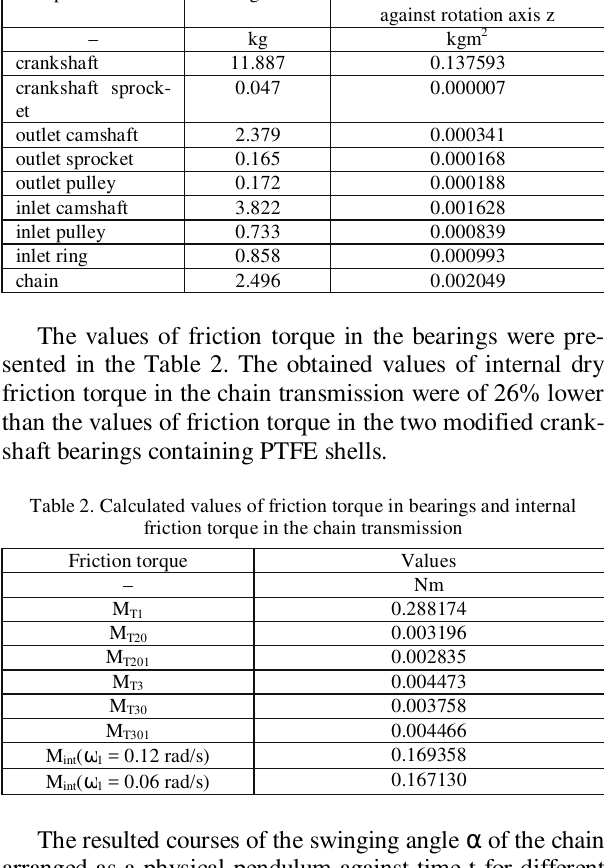
Table 1. Weights and mass inertia moments of chain transmission components Component